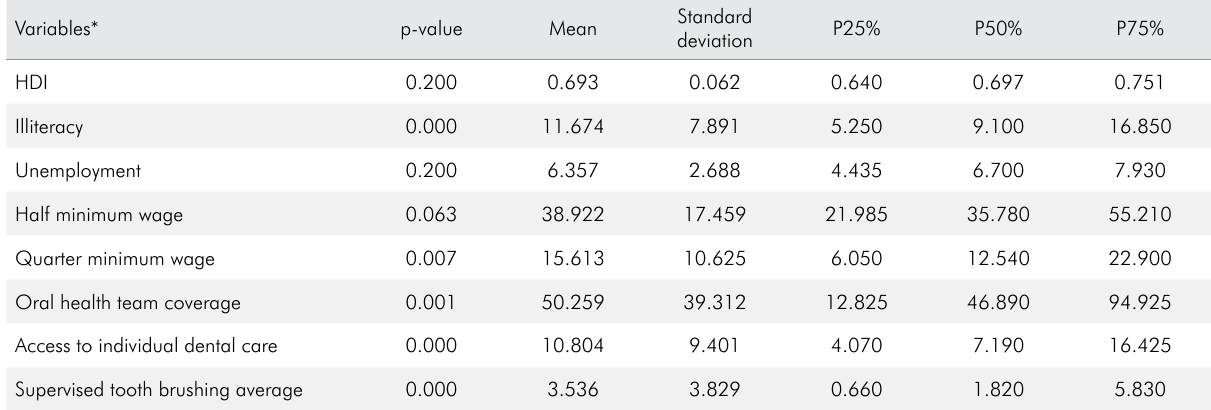
Table 3. Descriptive analysis of contextual variables from municipalities (n=57) in Minas Gerais, Brazil, 2012. Variables*